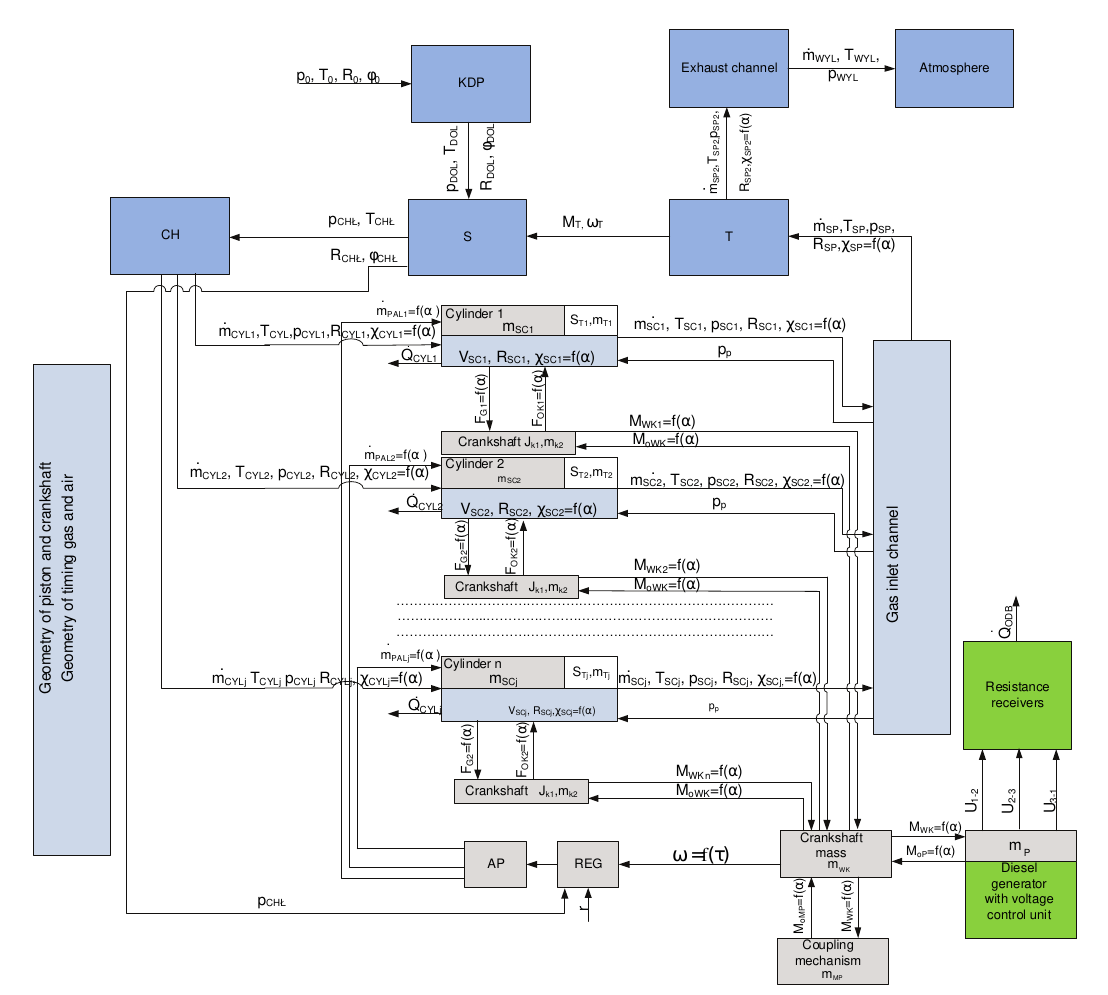
Fig. 4. Physical model of the marine generator